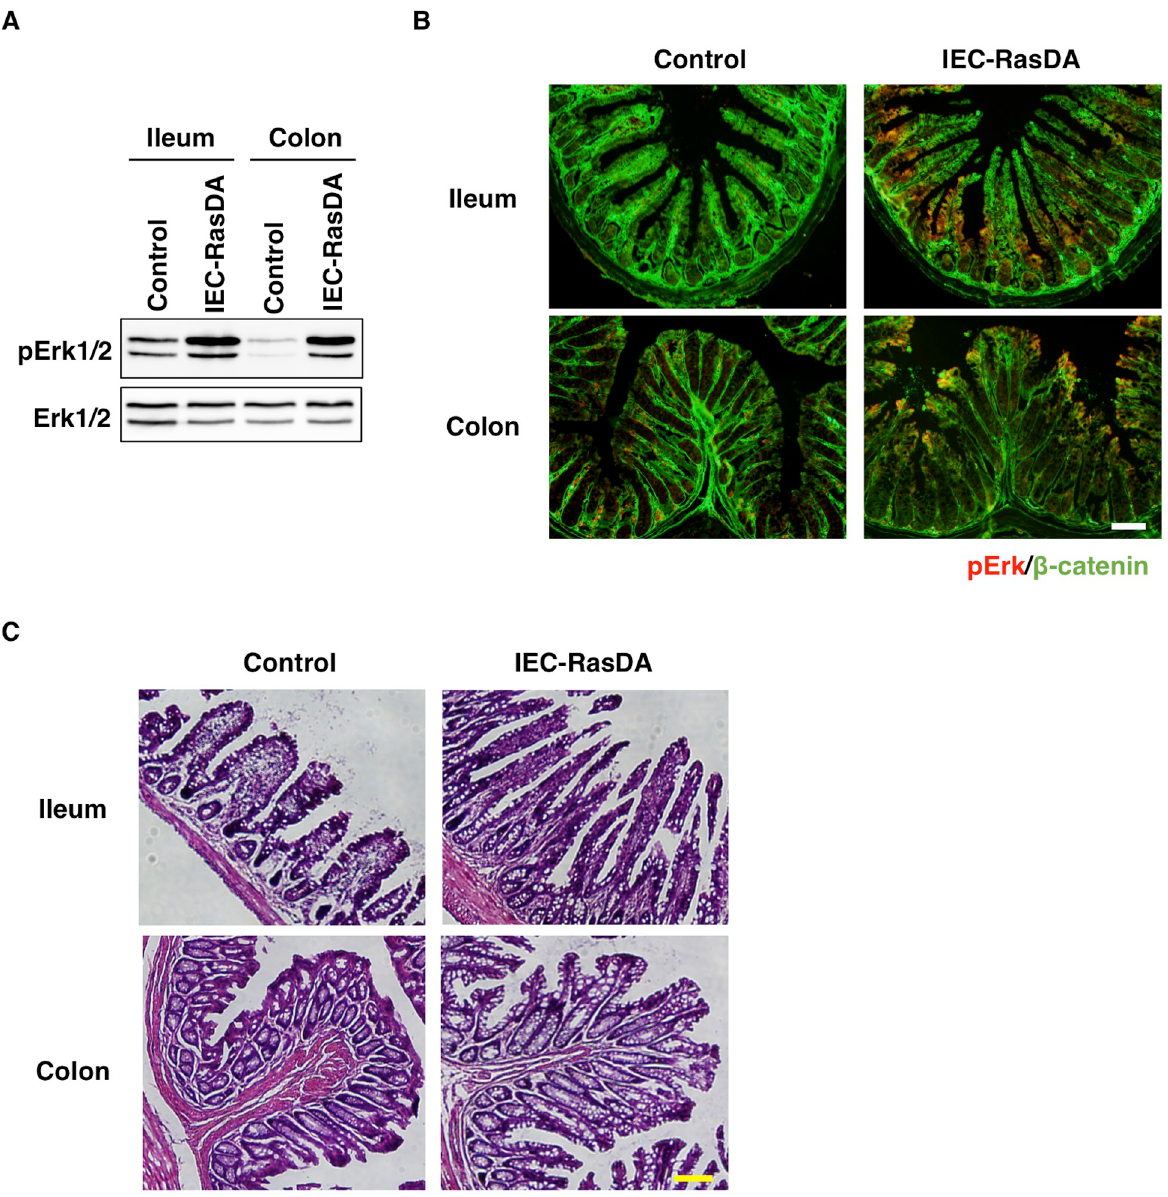
Fig 1. Hyperplasia of the intestinal epithelium in IEC-RasDA mice. ( A ) Lysates of the ileum and colon from control or IEC-RasDA mice at 12-week-old were subjected to immunoblot analysis with antibodies to phosphorylated (p) or total forms of Erk1/2. ( B ) Frozen sections of the ileum and colon from control or IEC-RasDA mice at 10-week-old were subjected to immunohistofluorescence analysis with antibodies to pErk1/2 (red) and to β -catenin (green). Scale bar, 100 μ m. ( C ) Hematoxylin-eosin staining of frozen sections of the ileum and colon from control or IEC-RasDA mice at 12-week-old. Scale bar, 100 μ